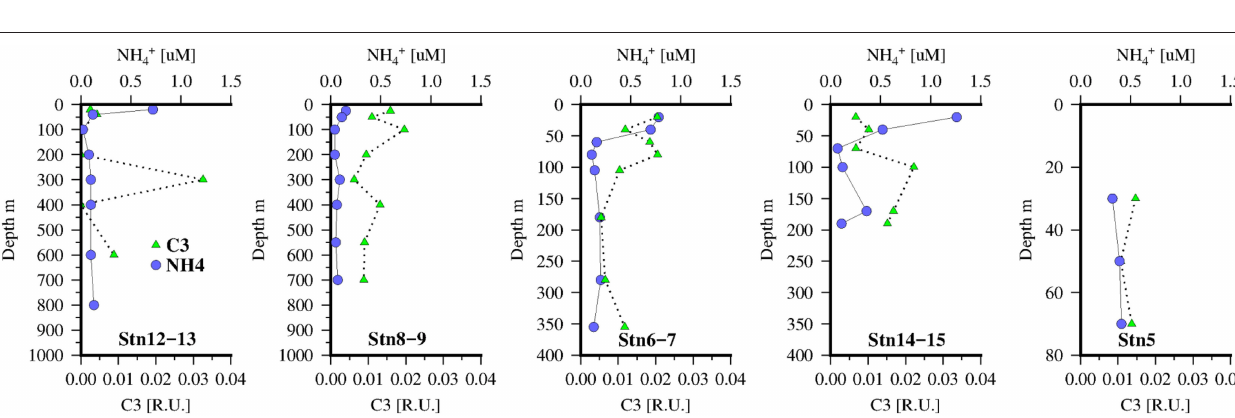
FIGURE 6 | NH + 4 concentrations (blue circles) and protein-like FDOM component identified by PARAFAC, C3 (green triangles) at 5 stations along the transect in the Mauritanian